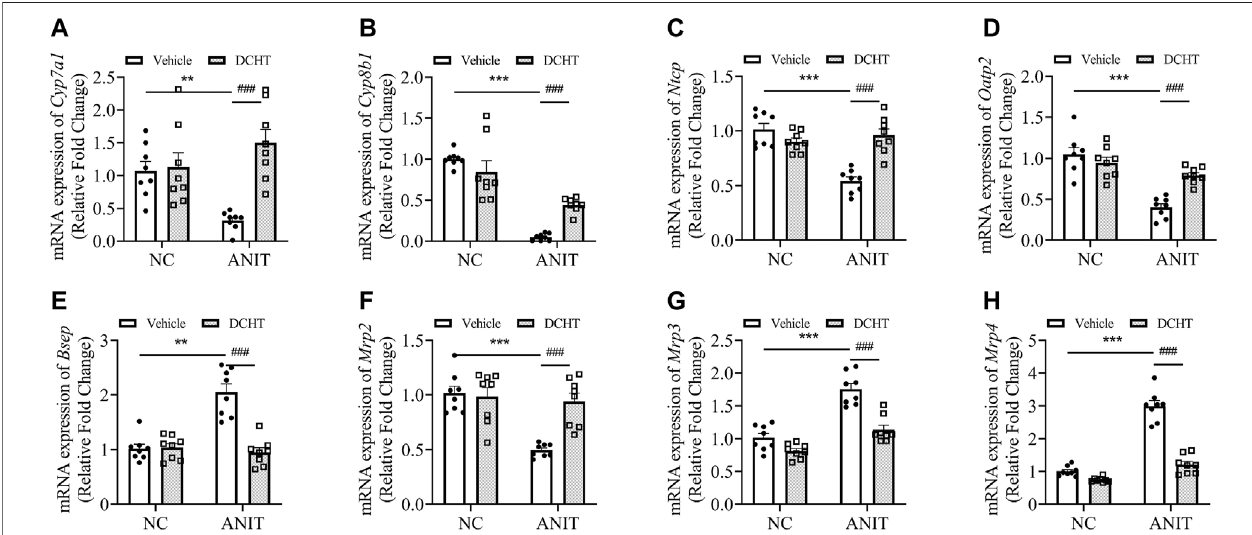
FIGURE2| DCHTaltershepaticmRNAexpressionofgenesrelatedtobileacidhomeostasisinANIT-inducedintrahepaticcholestasis invivo . (A-H) HepaticmRNA expression of Cyp7a1 (A) , Cyp8b1 (B) , Ntcp (C) , Oatp2 (D) , Bsep (E) , Mrp2 (F) , Mrp3 (G) and Mrp4 (H) was measured by qPCR after treatment of mice with ANIT (2 days) and/or DCHT (5 days, 1.875 g/kg), as indicated. Data are shown as means ± SEM.; ** p < 0.01, *** p < 0.001 compared with the vehicle group; ### p < 0.001 compared with the ANIT treatment group, n =